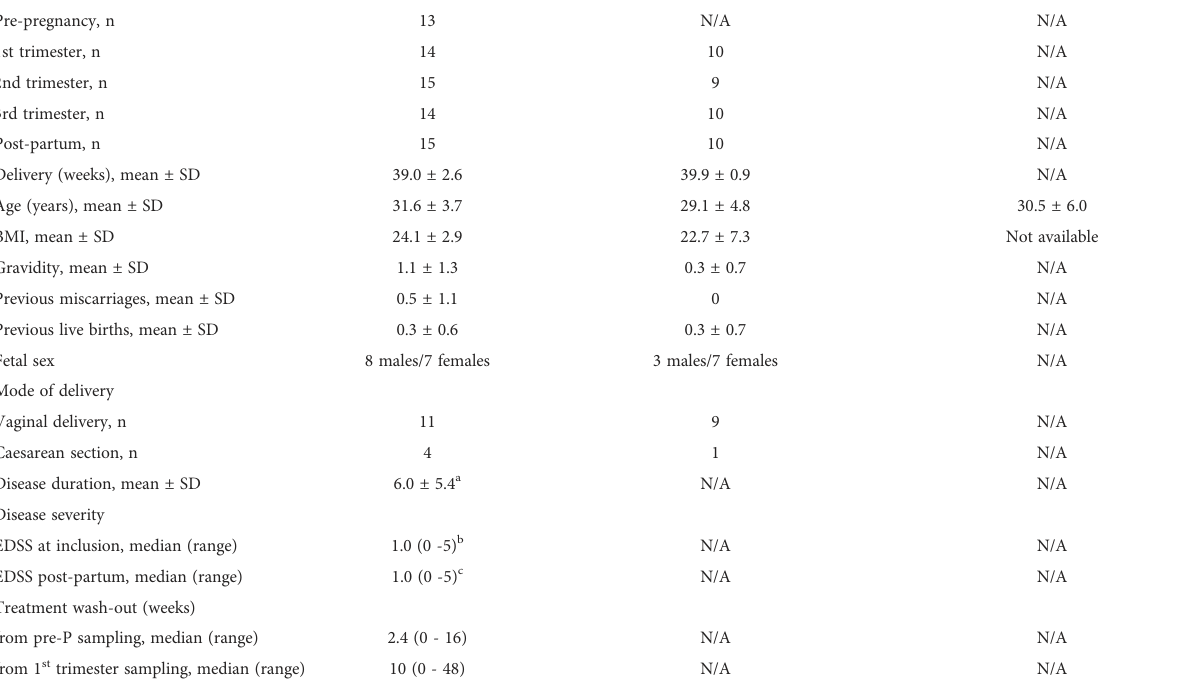
TABLE 1 Study cohort